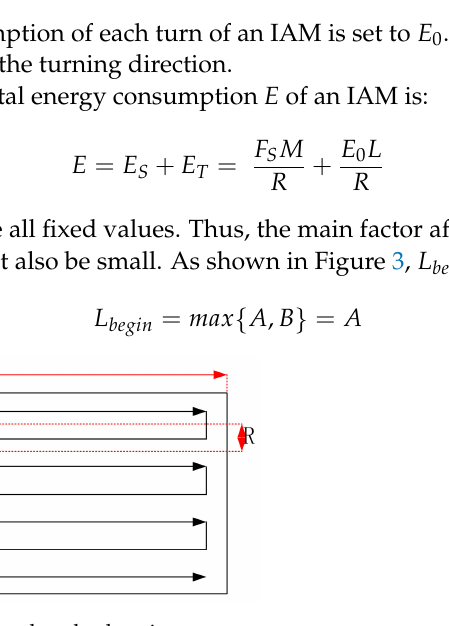
Figure 3. Round-trip traversal path